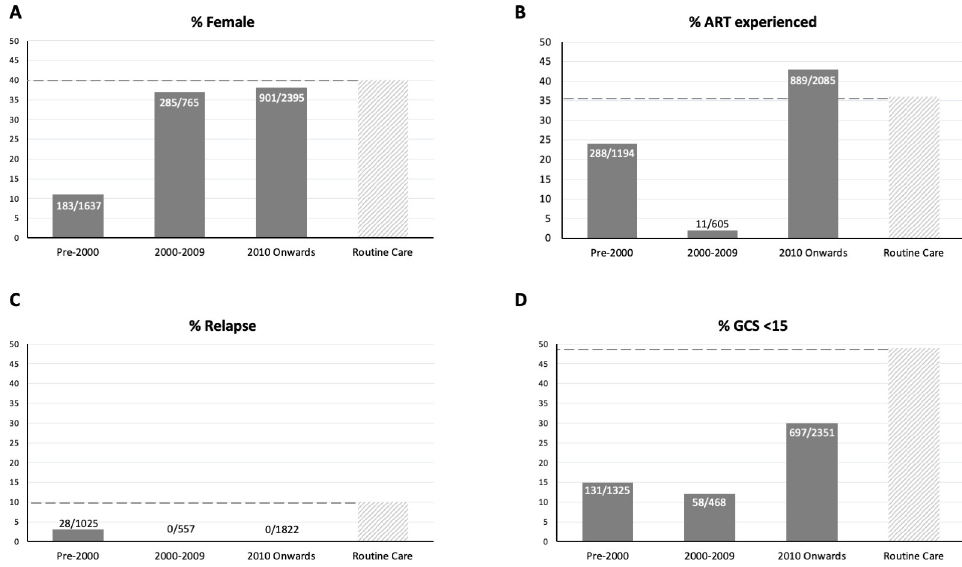
Fig 3. The characteristics of HIV-associated cryptococcal meningitis trial participants across 3 different time periods (pre-2000, 2000–2009, and 2010 onwards) broken down by (A) Sex, (B) ART experience, (C) Relapse, and (D) Baseline Glasgow Coma Scale (15) score, all compared with a composite reference from recently published observational